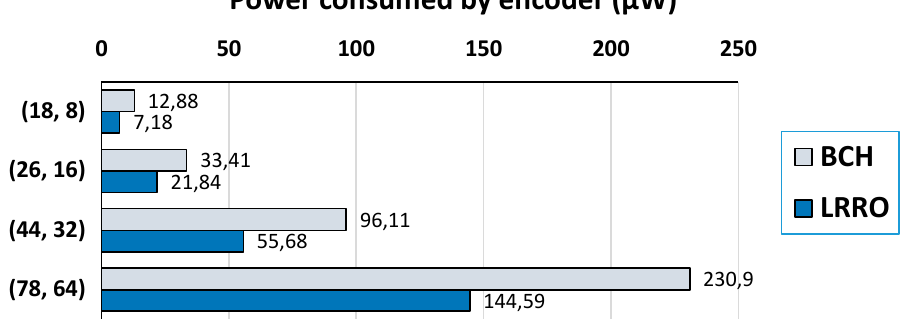
Figure 11. Power consumed by the encoder circuits (in µW).